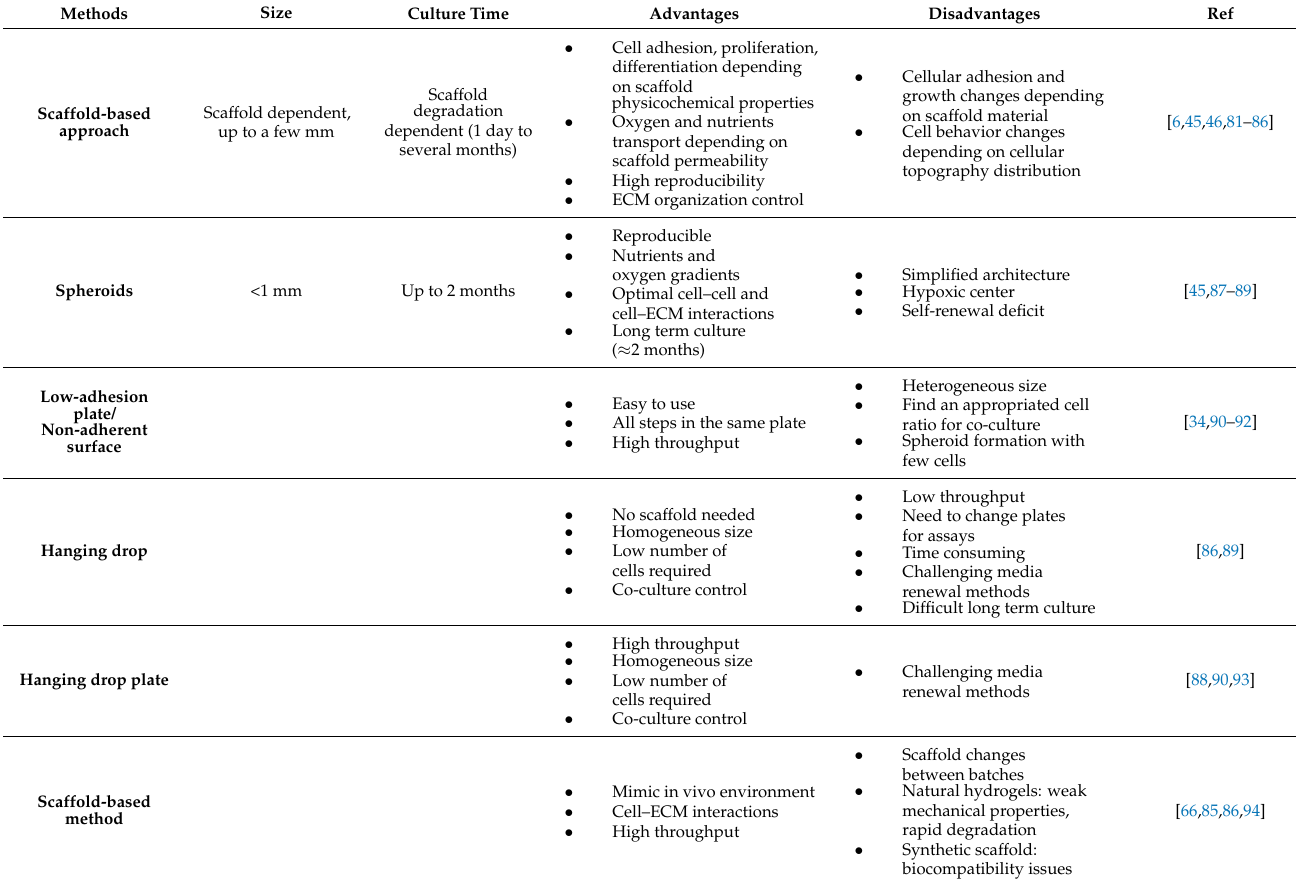
Table 2. Overview of in vitro 3D